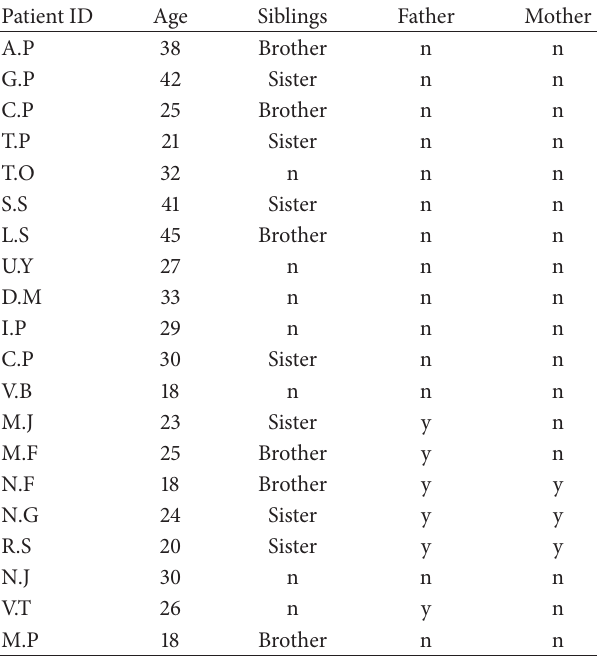
Figure 7: Anatomy of the tooth measured on periapical